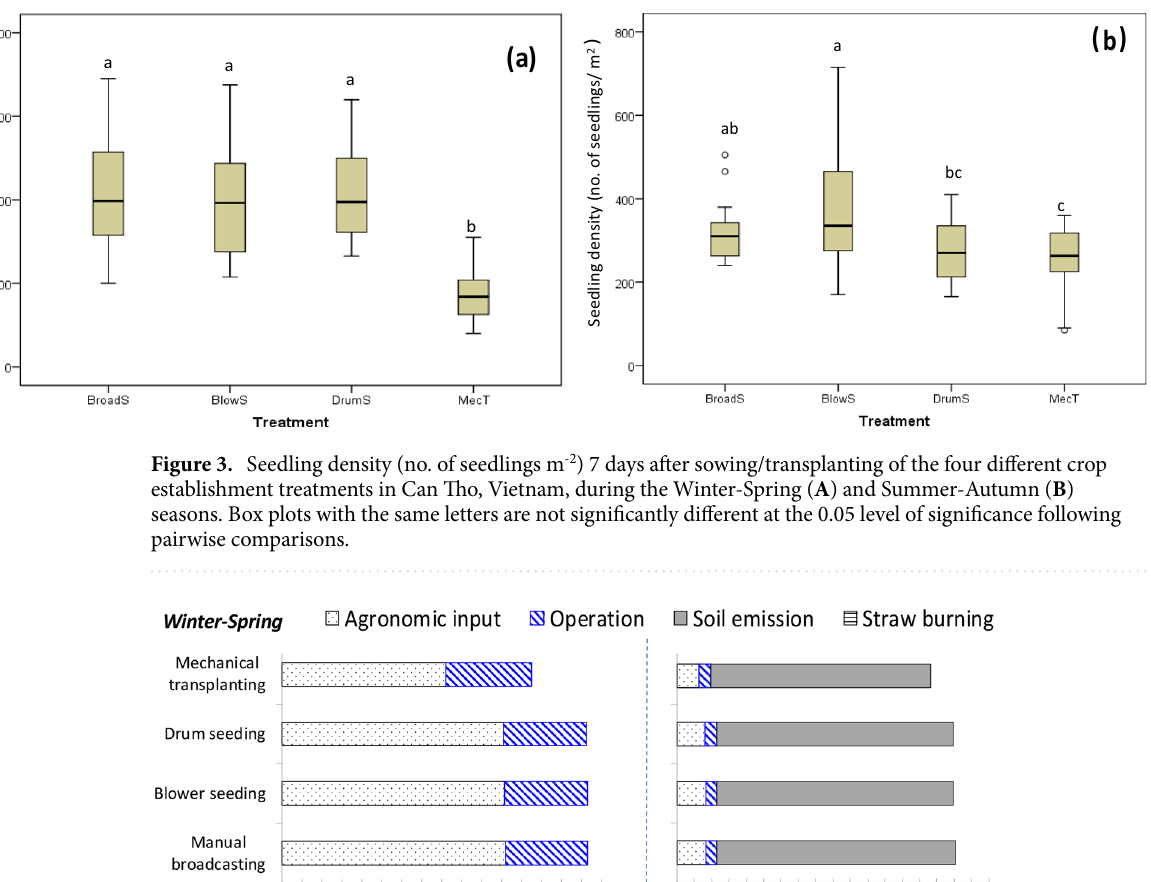
production across the four field trial treatments in the WS and SA seasons. There was no significant difference in N-P-K use efficiency (n = 4, P > 0.05). However, the farmers used less fertilizer for the MecT in the WS because of better rice plant growth and leaf color. As a consequence, MecT also had better mean energy efficiency. MecT had significantly lower pesticide use in the WS season. There was a significant difference in the number of pesticide applications between treatments ( F 9,3 = 5.121, P = 0.024), with the lowest number applied in the MecT treatment ( P < 0.005 ). MecT required less pesticides because of increased rice plant vigor and lower plant density (Fig. 5). During the SA season, farmers applied less fertilizer and pesticide than in the WS season, with no sig-